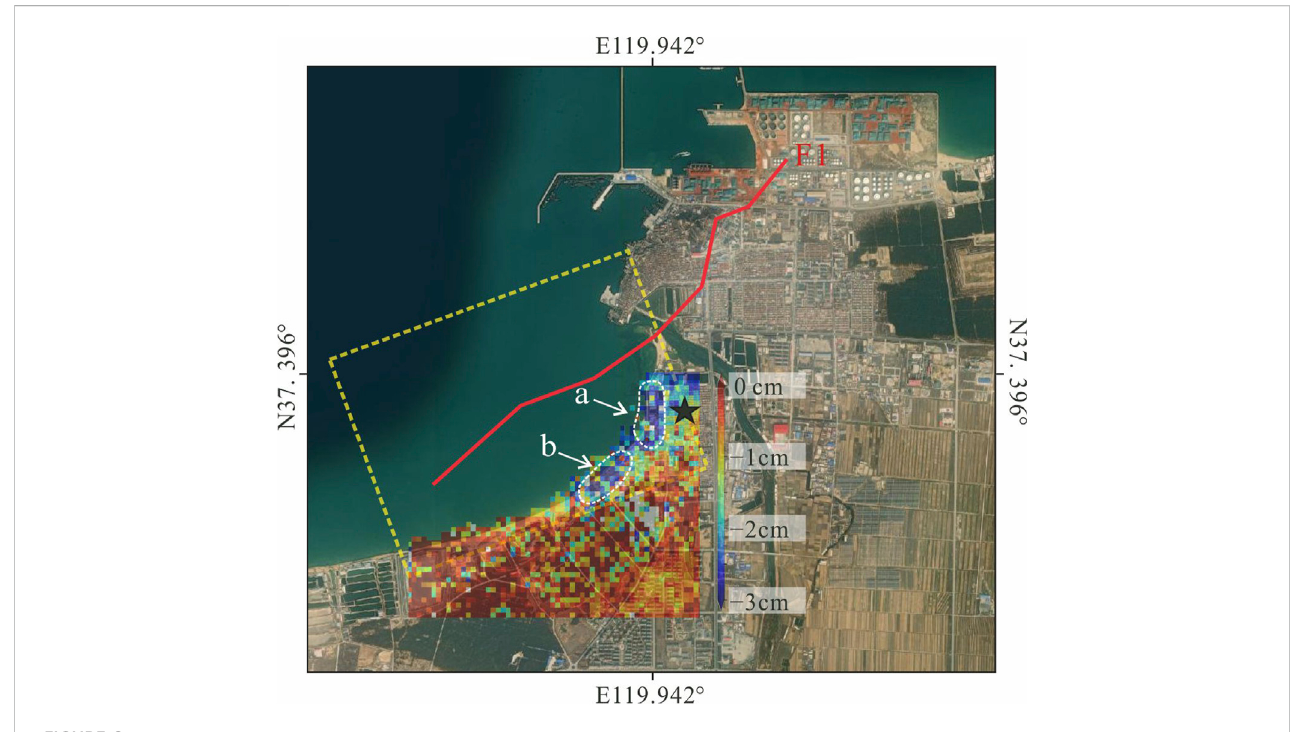
FIGURE 6 Spatial characteristics of the LOS displacement fi eld (SBAS